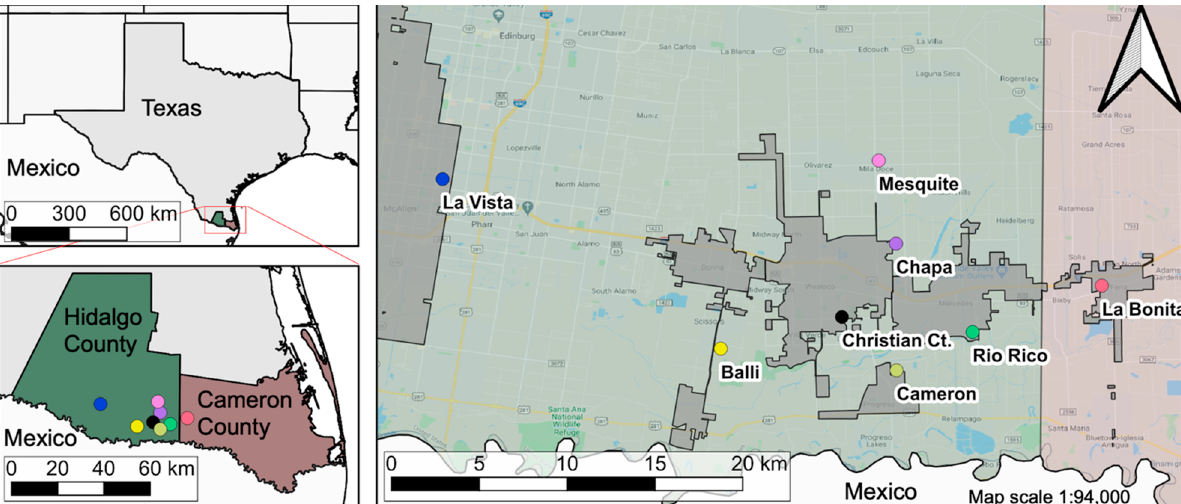
Figure 1. Location of the Lower Rio Grande Valley communities where the Autocidal Gravid Ovitrap surveillance took place. City limits of the communities are shown as a transparent gray area. Only middle-income communities are found within city limits; low-income communities are incorporated into the management area of Hidalgo County. The map was developed using QGIS 3.10 with publicly available administrative boundaries.